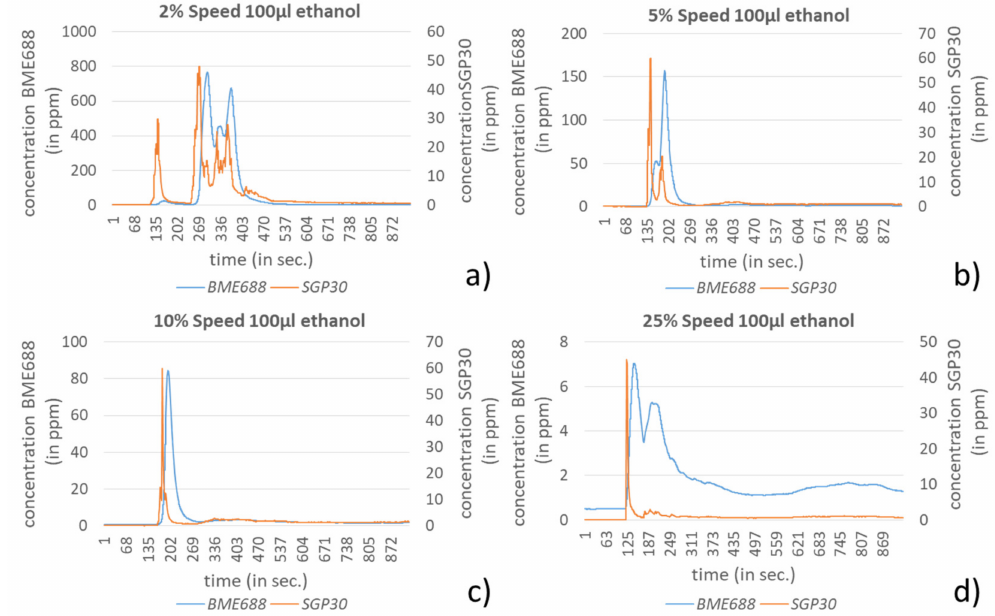
Figure 16. Results for the detection of 100 µ L ethanol during a pick and place procedure using a TS60 at different speed levels, ( a ) for 2%, ( b ) for 5%, ( c ) for 10% and ( d ) for